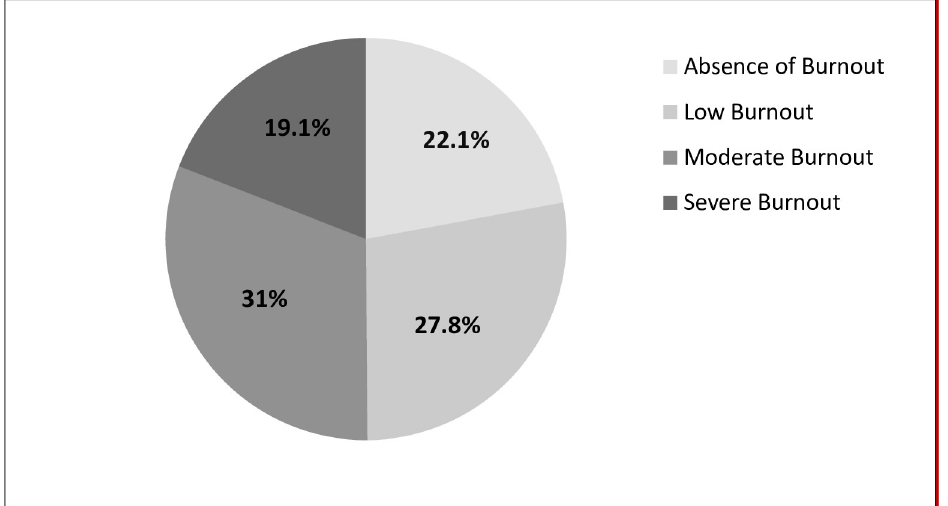
Fig 1. Distribution of the study population according to the level of